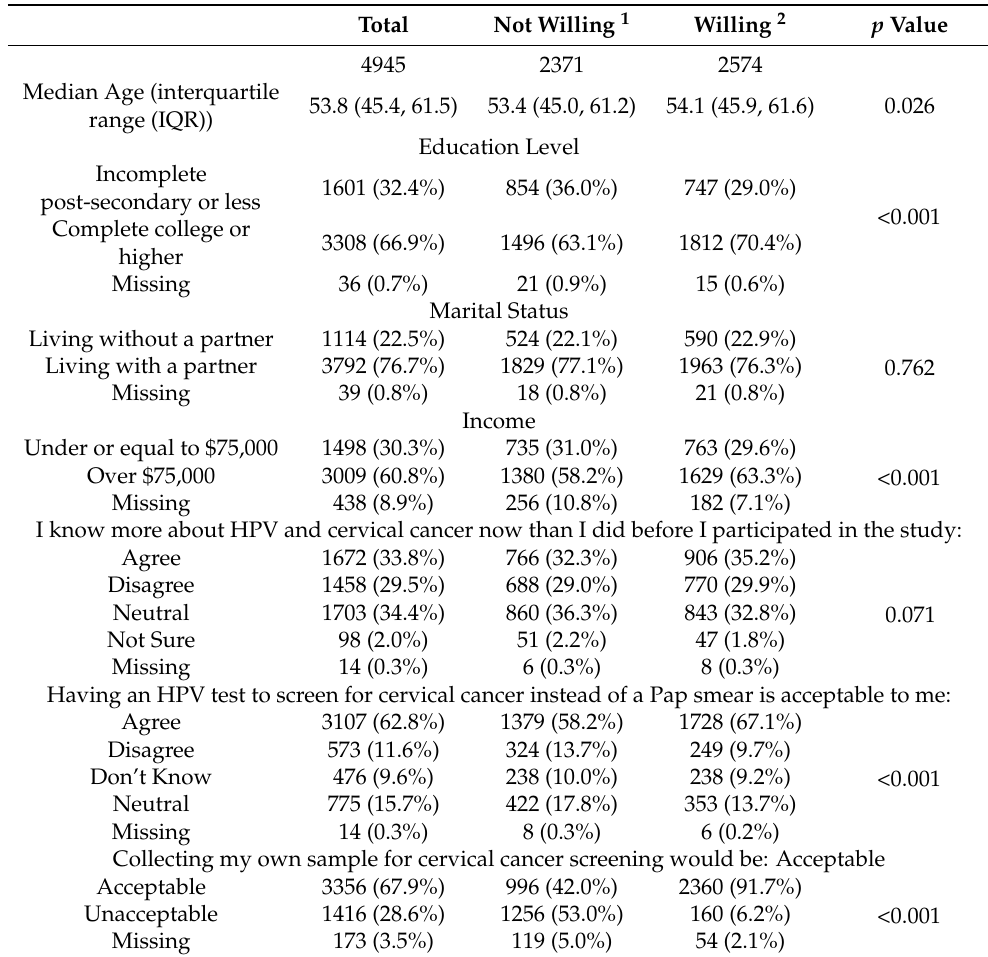
Table 1. Bivariate analysis of correlates of participants’ willingness to self-collect a vaginal sample for HPV-based cervix screening. Total